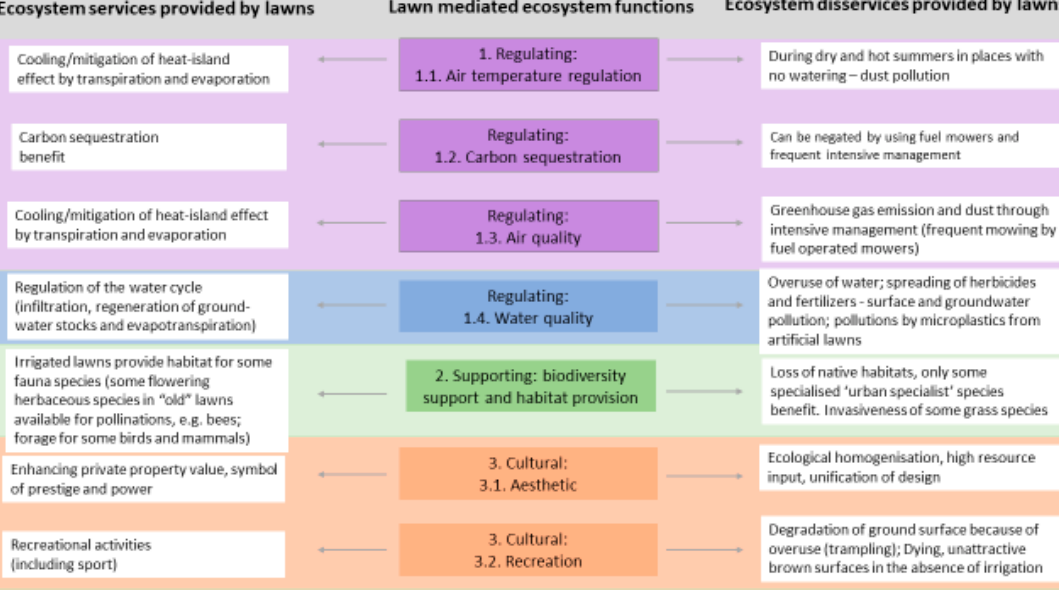
Figure 3. Lawn as a special leisure space in urban parks worldwide: ( a ) King’s Park in Perth, Australia; ( b ) Lene-Voigt Park in Leipzig, Germany; ( c ) one of the public parks in Xian, China. Photos: M. Ignatieva, D. Dushkova.